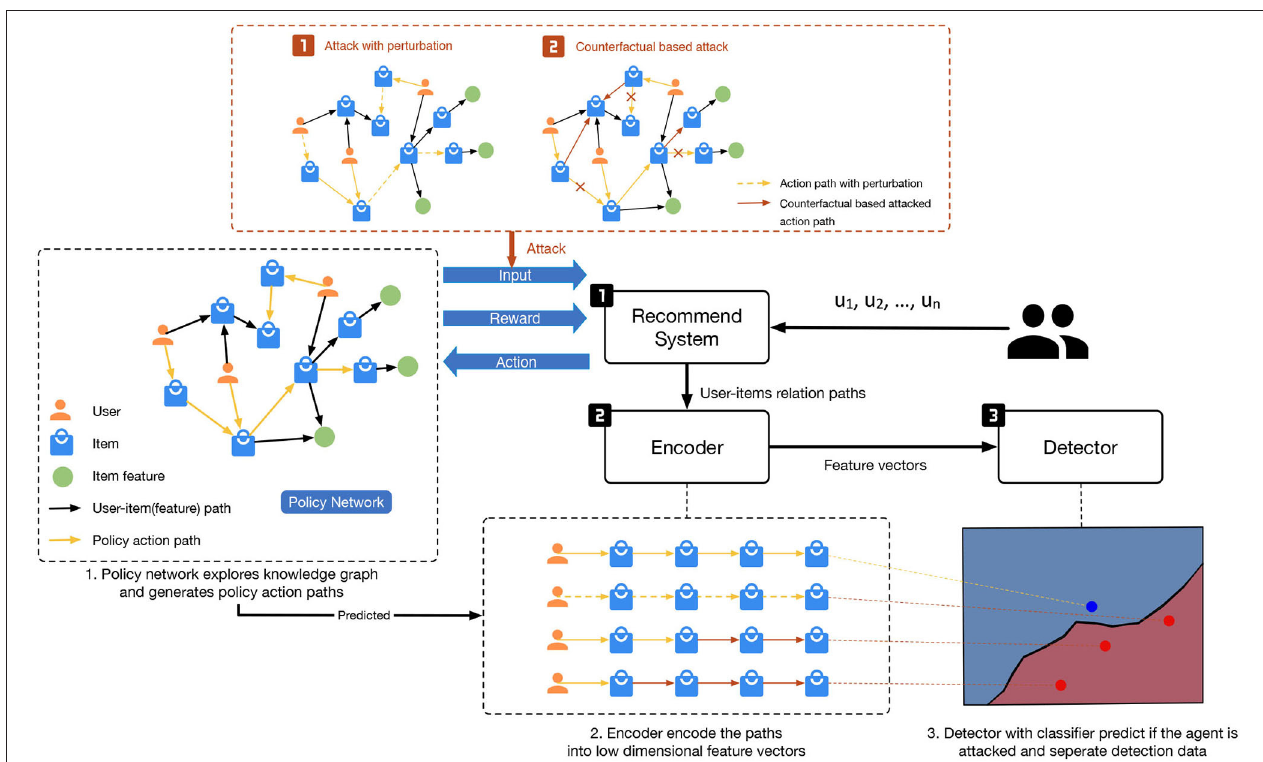
FIGURE 1 | Our proposed Adversarial Attack and Detection Approach for RL-based Recommender